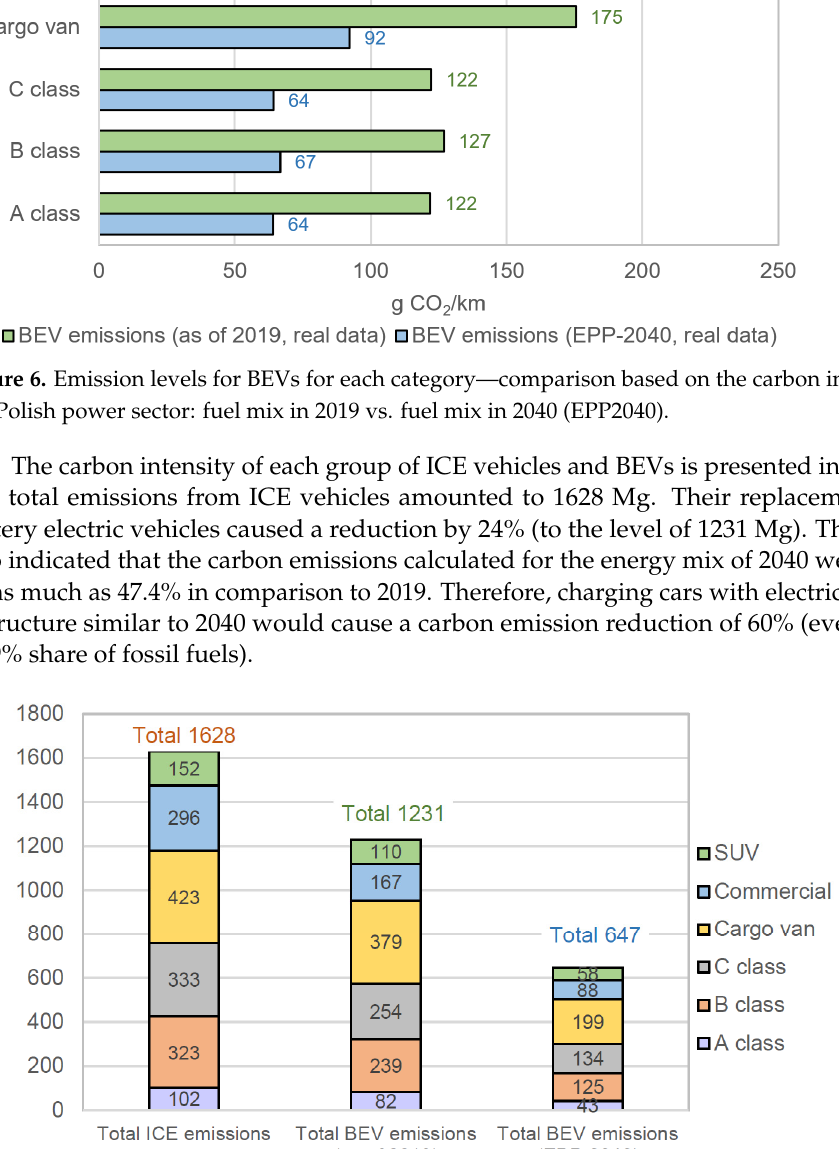
050100150200250300350 Figure 8. Breakdown of total carbon emissions (Mg) across vehicle categories of the Polish carbon intensity of electricity generation as of 2019 and in 2040 (EPP2040).